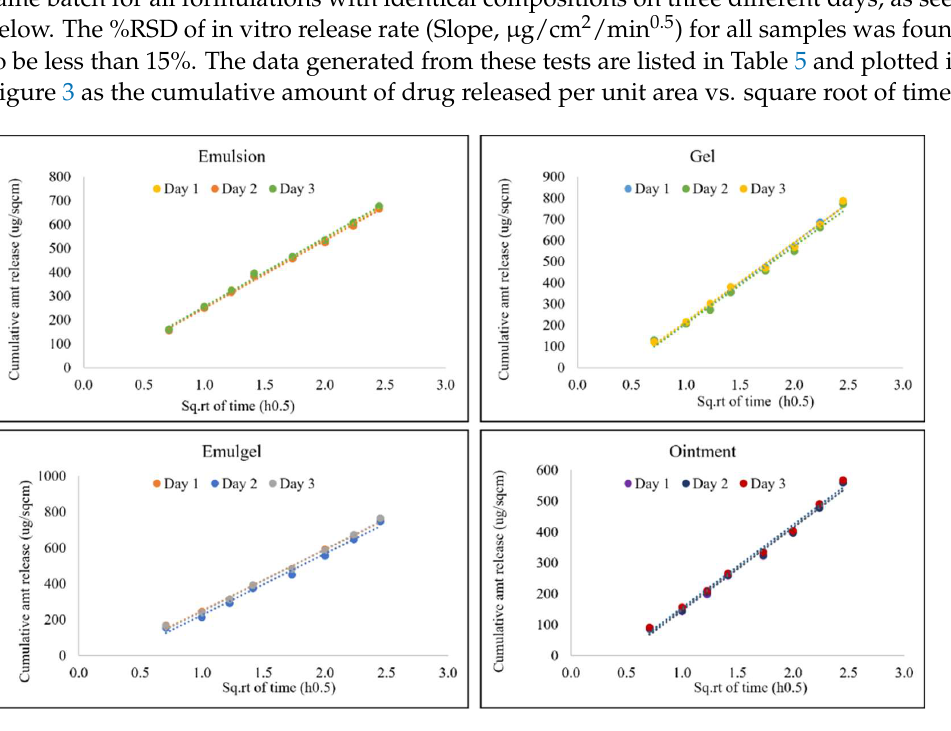
Figure 3. Inter-day precision for all semi-solid formulations. Data shown as mean release rate (µg/cm 2 /min 0.5 ) and % RSD for six replicates. Table 5. Inter-day precision data for the semi-solid formulations. Data shown as mean release rate (µg/cm 2 /min 0.5 ) and % RSD for six replicates.